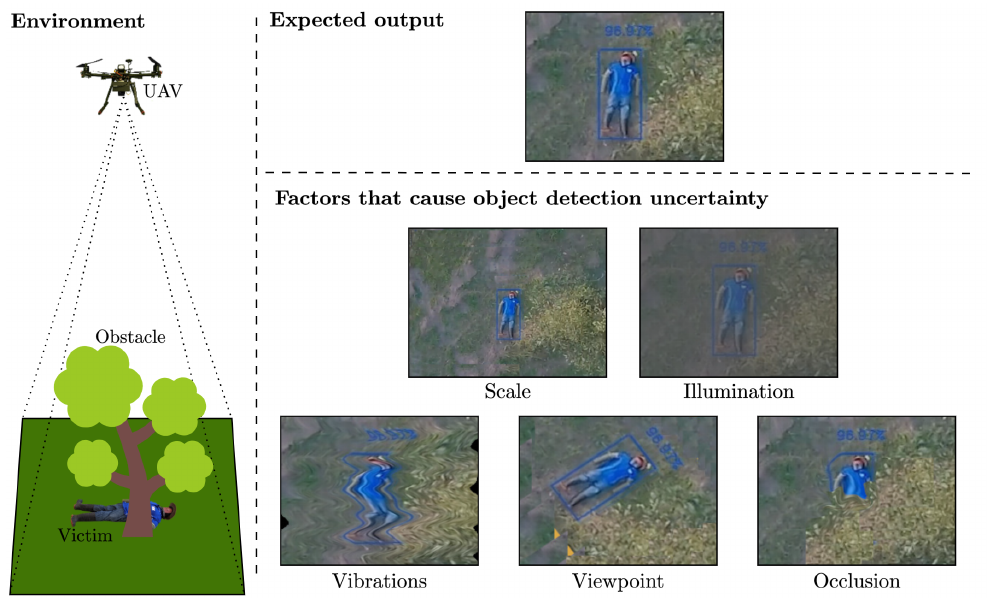
Figure 1. Factors that can cause object detection uncertainty and partial observability during UAV surveys. Incorporating algorithms in decision-making under uncertainty onboard UAVs increase their reliability to explore complex and time-critical environments, such as search and